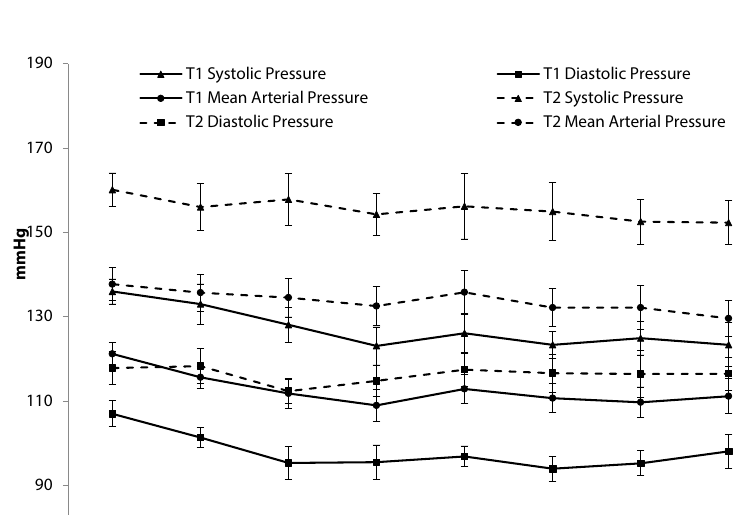
Figure 4: Changes in blood pressure over time (minutes) in blesbok immobilised with T1 (etorphine + azaperone) and T2 (etorphine + midazolam)